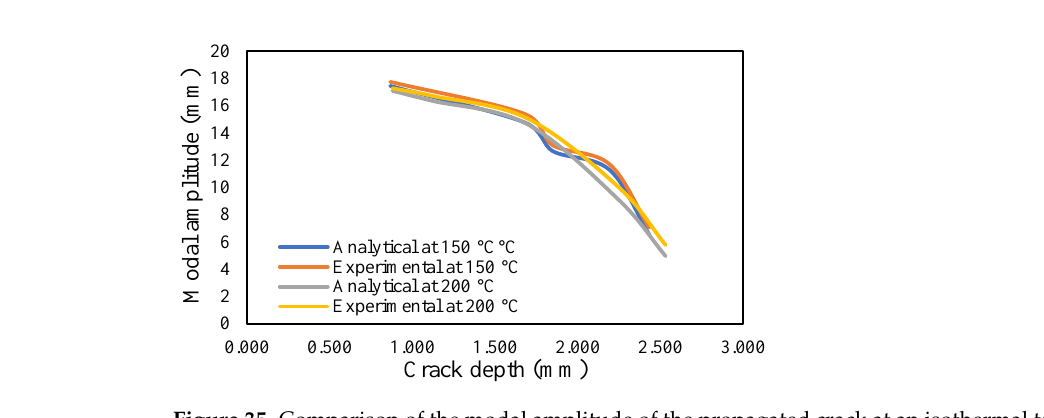
Figure 35. Comparison of the modal amplitude of the propagated crack at an isothermal temperature of 150 and 200 °C.